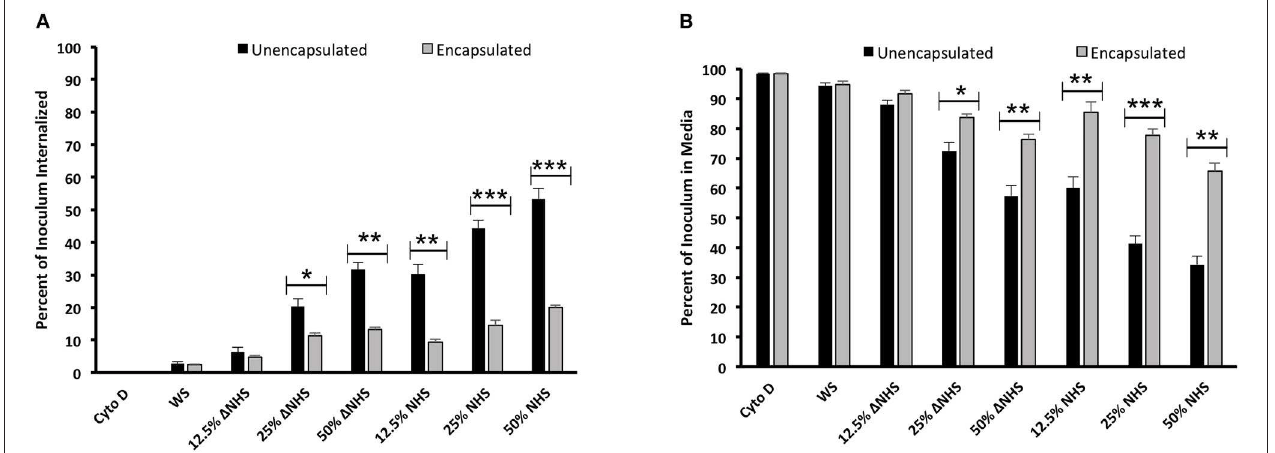
FIGURE 1 | Differential phagocytosis of encapsulated and non-encapsulated strains of Bacillus anthracis active bacteria by human monocyte-derived macrophages. THP-1 macrophage cells were infected with B. anthracis in media supplemented with different concentrations of normal human serum (NHS; 12.5–50%) and heat-treated human serum ( 1 NHS, 12.5–50%). (A) Internalized surviving bacteria obtained from lysed macrophages post-phagocytosis represented as percent of B. anthracis inoculum. (B) Percent of B. anthracis inoculum (non-internalized) surviving in the media post incubation with THP-1 macrophages. Black and gray bars represent non-encapsulated and encapsulated strains, respectively. Cytochalasin D (Cyto D)-treated THP-1 cells that have lost their phagocytic ability were considered as negative control. Each bar represents the mean of three independent experiments. Error bars represent standard error of the mean. WS, media without serum. Statistical significance is highlighted by the following denotations: * for P -value < 0.05, ** for P -value < 0.01, and *** for P -value <